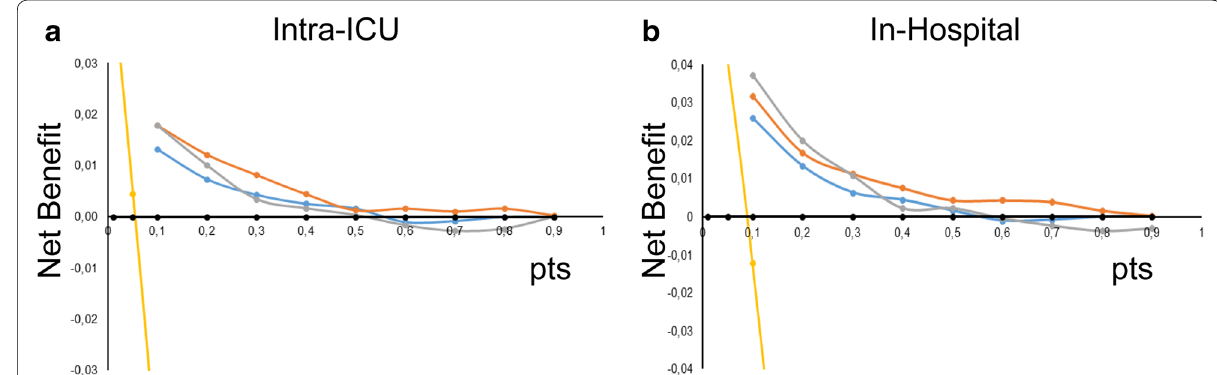
Fig. 4 Prediction models decision curves. a , b The net benefits of using each prediction model (on the y -axis) plotted for different thresholds of the probability of intra-ICU ( a ) or in-hospital ( b ) deaths (on the x -axis). The net benefit was calculated according to the following formula: net benefit [(true-positive count)/ n ] [(false-positive count)/ n ] [pt/(1 pt)] where n is the total number of patients and pt the threshold = − × − probability. Two lines representing the net benefit associated with the strategy of assuming all patients survived (no false positives) (black line) and that all patients died (yellow line) was drawn for comparison. Orange line—APACHE II; blue line—SOFA; gray line—SAPS